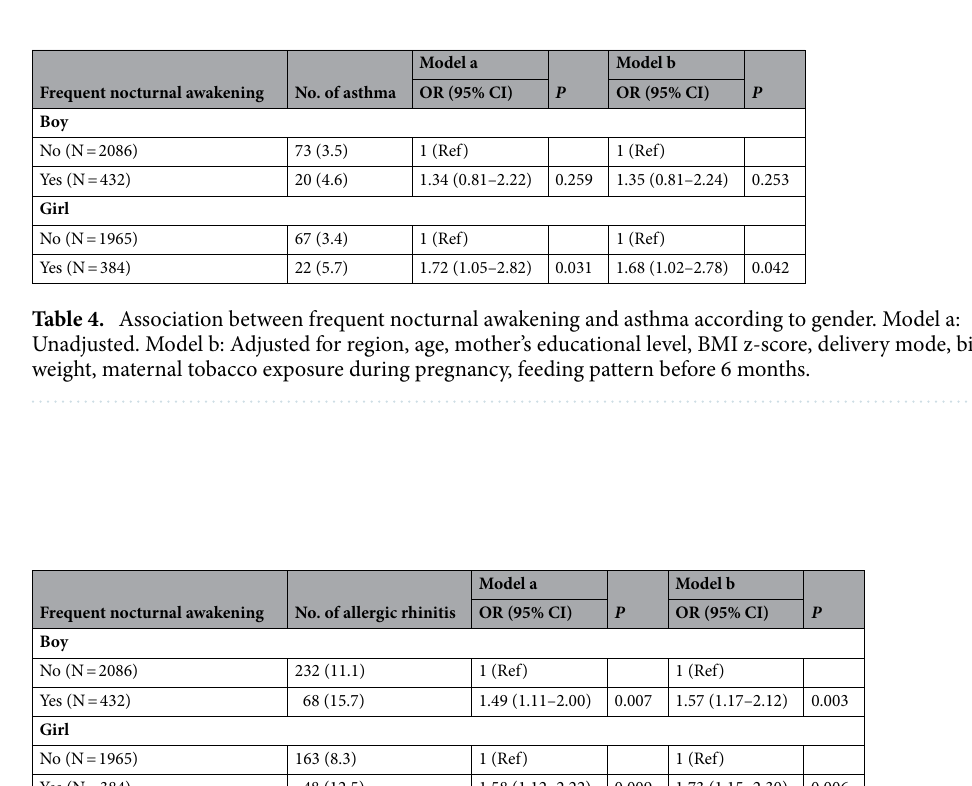
Table 3. Association of sleep problems with asthma or allergic rhinitis among per-school children. a Model 1: Unadjusted. b Model 2: Adjusted for region, gender, age, mother’s educational level, and BMI z-score. c Model 3: Additionally adjusted for delivery mode, birth weight, and maternal tobacco exposure during pregnancy, feeding pattern before 6 months.